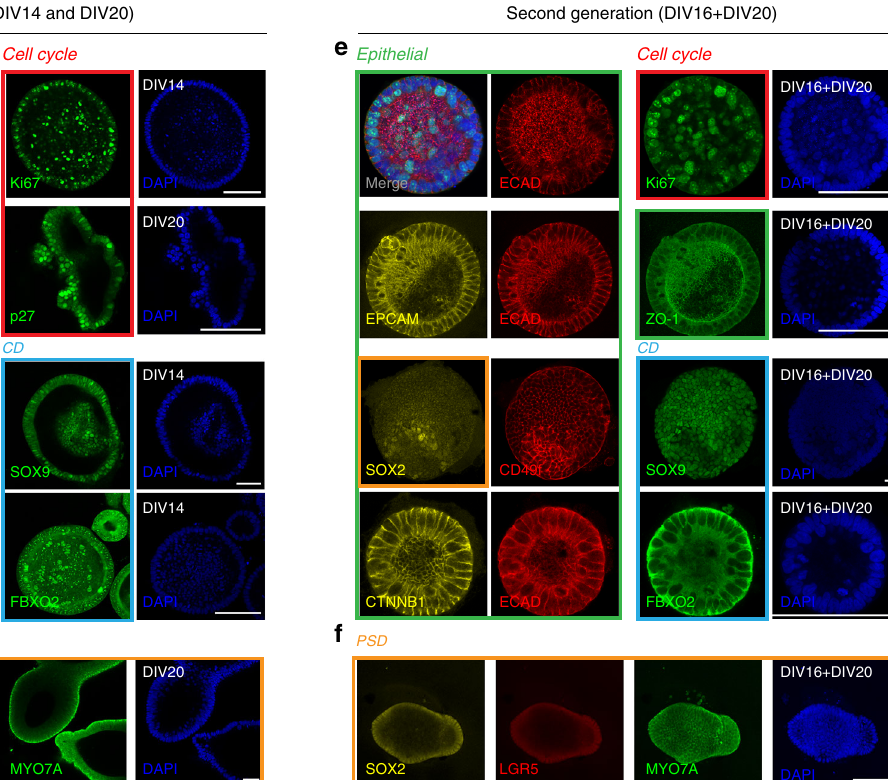
Fig. 4 Organoid generation and characterization. a Human fetal cochlea at W10 (sample E1201) immunostained for EPCAM and FACS plot showing the gating of EPCAM-positive cochlear duct cells. Also shown is a schematic overview of the procedure for organoid generation. b Representative examples of EPCAM + and EPCAM − derived cultures at day 7 (DIV7) and day 20 (DIV20) in vitro (sample E1220). EPCAM negative cells immunostained at day 13 for nestin (NES), peripherin (PRPH), and β III Tubulin (TUBB3). EPCAM-positive organoids immunostained at day 20 in vitro for MYO7A. F-actin was labeled with phalloidin. Scale bar = 100 μ m. c – d Immunostaining of 1st generation organoids (E1220 and E1253) at DIV14 and DIV20 for the proteins indicated. Colored boxes indicate marker classes: epithelial (green), cell cycle (red), cochlear duct (light blue), and PSD markers (orange) are shown. Scale bar = 100 μ m. e – f Immunostaining of 2nd generation organoids (E1224) at DIV16 + DIV20 (days 1st generation + days 2nd generation) for the proteins indicated; marker classes are indicated by the colored boxes. Scale bar = 100 μ hair cells of the four groups. The number varied from 20 cells to maximal 180 MYO7A + cells ( n = 45 organoids assessed).